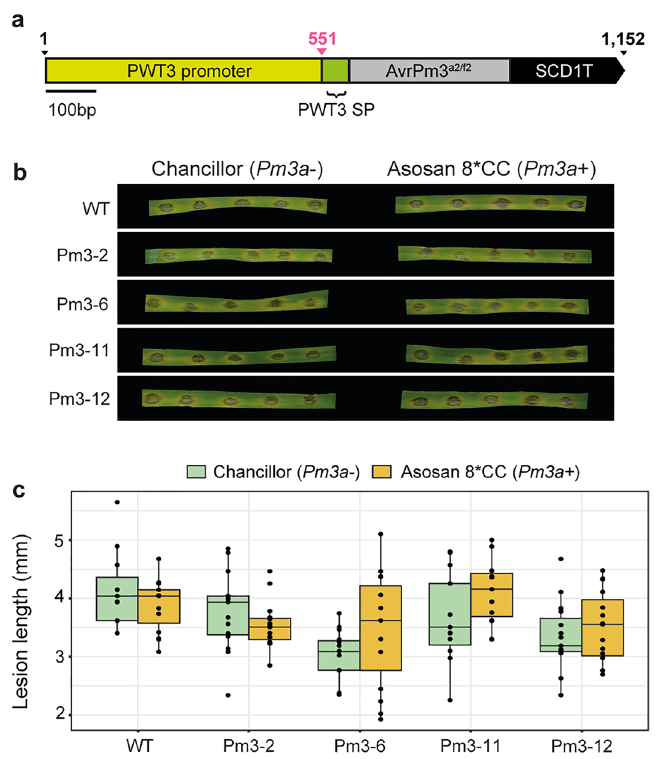
Figure 5. Introduction of the Blumeria graminis avirulence effector AvrPm3 into MoT did not lead to a visible Pm3 -dependant HR phenotype. ( a ) Schematic representation of the pCB-PWT3p-PWT3SP-AvrPm3 a2/f2 - stop vector used for transformation of MoT (strain N06047). Scale bar represents 100 bp; SP, signal peptide. ( b,c ), Introduction of the PWT3p::PWT3SP:: AvrPm3 a2/f2 transgene into MoT failed to induce a visible Pm3 -mediated hypersensitive response (HR), when transformants were inoculated onto the wheat line Asosan 8*CC ( Pm3 +). The second leaf of two-week old wheat seedings of the lines Asosan 8*CC ( Pm3 +) and Chancillor ( Pm3- ) were inoculated with conidial suspensions derived from four separate transformants (Pm3-2, Pm3-6, Pm3-11 and Pm3-12) and the wild-type (WT) MoT strain N06047 using the spot inoculation method. Images were taken and lesion lengths measured at 4 days post-inoculation, with three biological replicates conducted (separate